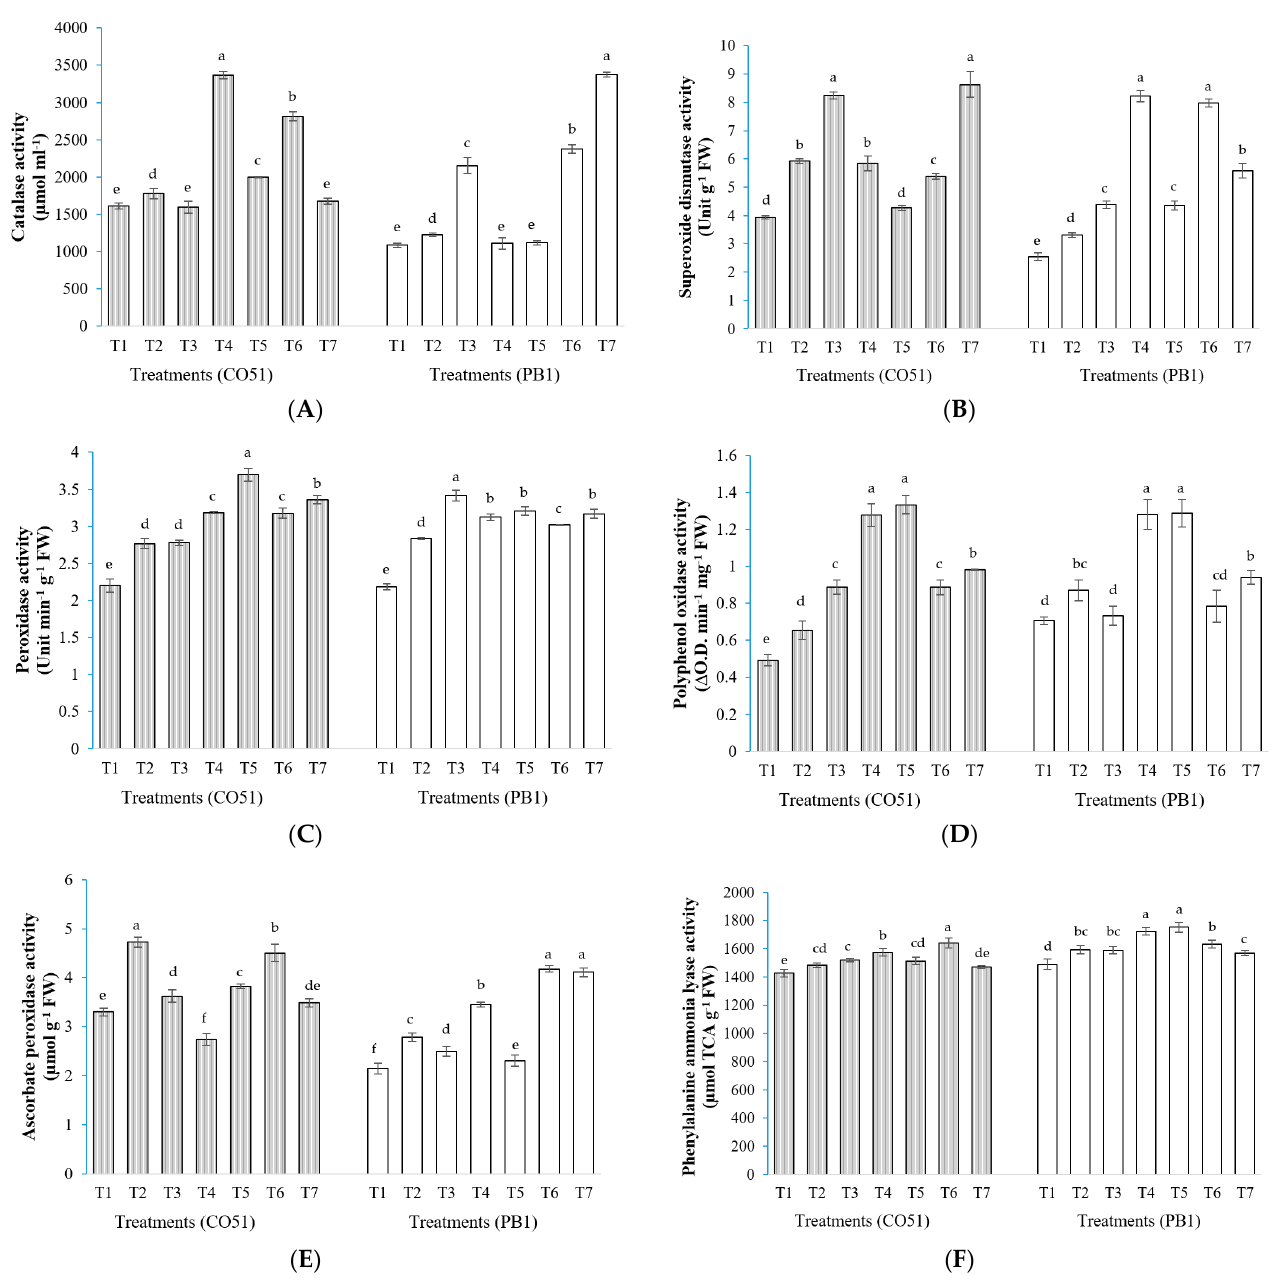
Figure 4. Effect of inoculation of halotolerant endophytes and rhizobacteria on the antioxidant enzyme activity in two rice varieties, CO51 and PB1. ( A ) Catalase, ( B ) Superoxide dismutase, ( C ) Peroxidase, ( D ) Polyphenol oxidase, ( E ) Ascorbate peroxidase, and ( F ) Phenylalanine ammonia lyase. T1 = Negative control, T2 = Positive control (200 mM NaCl), T3 = 200 mM NaCl + Trichoderma viride , T4 = 200 mM NaCl + Bacillus haynesii 2P2, T5 = 200 mM NaCl + Bacillus safensis BTL5, T6 = 200 mM NaCl + Brevibacterium frigoritolerans W19, and T7 = 200 mM NaCl + Pseudomonas fluorescens. The treat- ment data with the same letters within the same cultivar are statistically non-significant at p ≤ 0.05. Means are separated by Duncan’s multiple range test. Error bars indicate standard